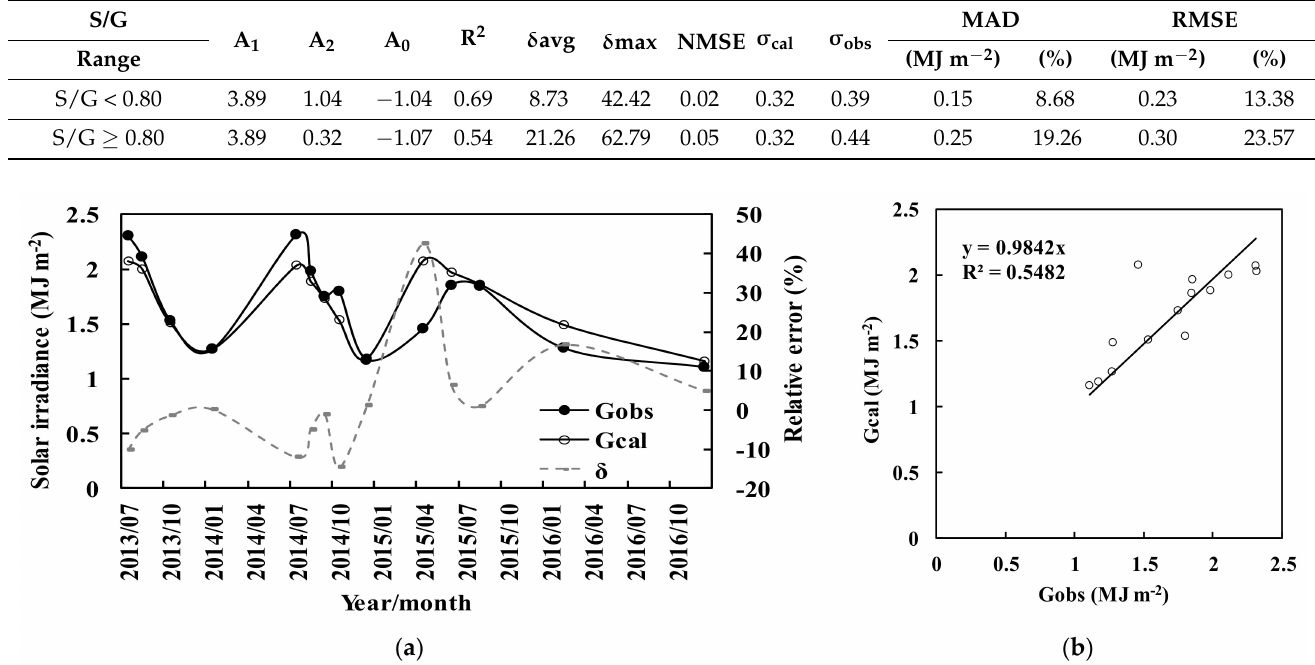
Table 1. Coefficients and constants for the empirical model of global solar irradiance (Equation (3)), determined using measurements in the Qianyanzhou Pinus forest in 2013–2016, together with statistical metrics, i.e., coefficient of determi- nation (R 2 ), average and maximum of the absolute relative bias ( δ avg, δ max (%)) normalized mean-square error (NMSE), standard deviations of calculated and observed global solar irradiances ( σ cal and σ obs respectively), and the mean bias error (mean absolute deviation (MAD), in MJ m − 2 and %), and the root-mean-square error (RMSE, in MJ m − 2 and %). n = 14 for S/G < 0.80, and n = 29 for S/G ≥ 0.80.